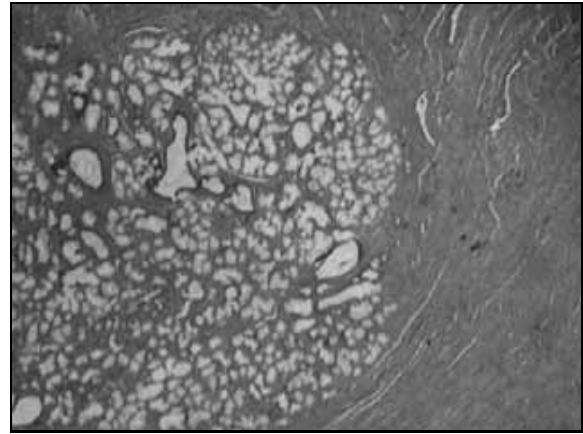
Figure 4 – Acinar cells’ characteristic: clear cytoplasm and basal nucleum (HE, magnification 200×) HE: hematoxylin and